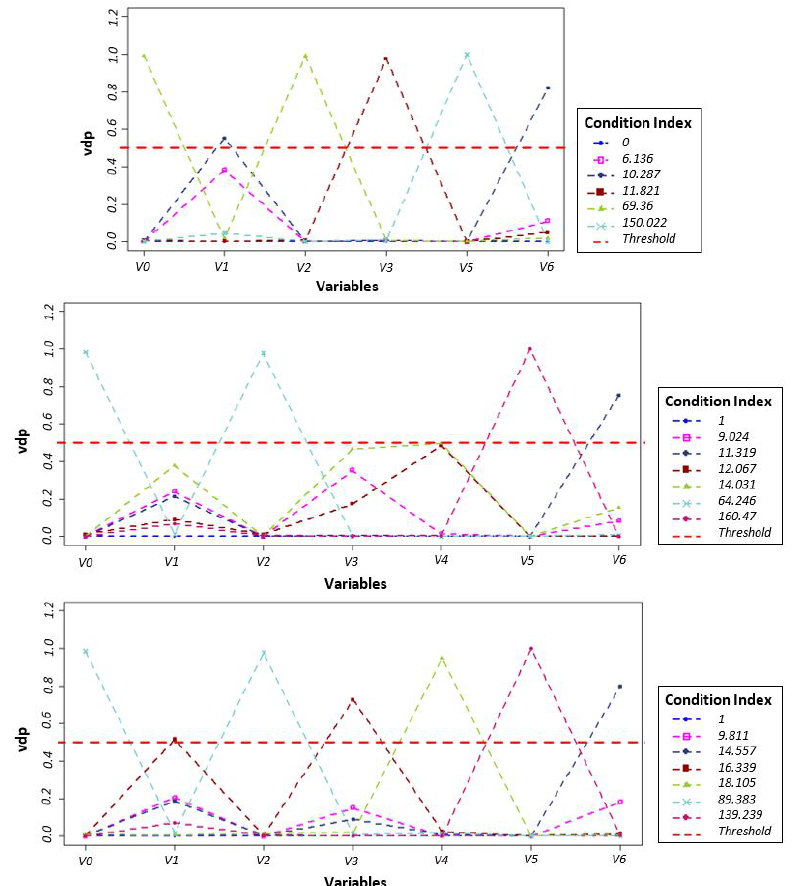
Figure 6. Multicollinearity Diagnostics Analysis of the Variables in OLS Regression Model; V 0 : Intercept, V 1 : Distance to MSAs, V 2 : Inverse distance to developed lands, V 3 : Inverse distance to coal mining sites, V 4 : Inverse distance to shale gas, V 5 : Population density, V 6 : Economic index; Top : 1985 − 1995, Middle : 1995 − 2005, Lower : 2005 − 2015. Variables which demonstrate a condition index of higher than 10 and vdp of greater than 0.5 (threshold line) have multicollinearity.